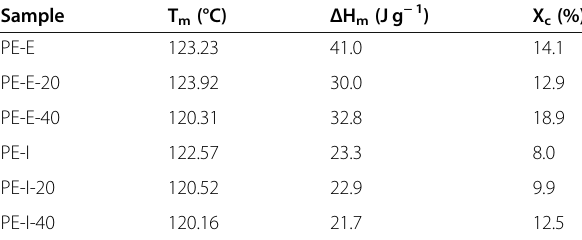
Table 4 Thermal behavior and crystallization degree of composites